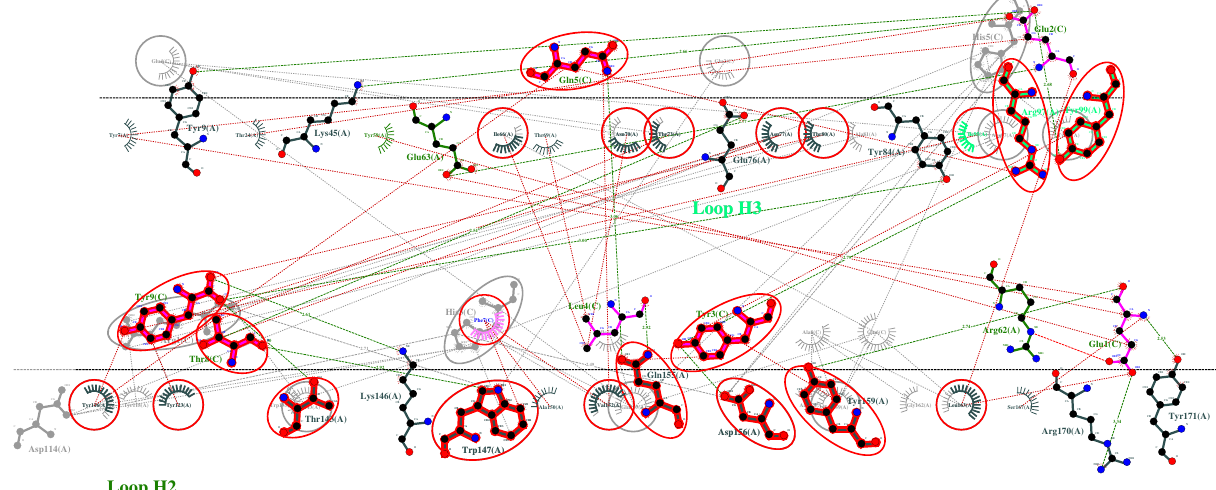
Figure 3. The interactions between HLA-B44 (PDB ID: 3KPS) and the epitope REHEHEIAW from the SARS- CoV-2